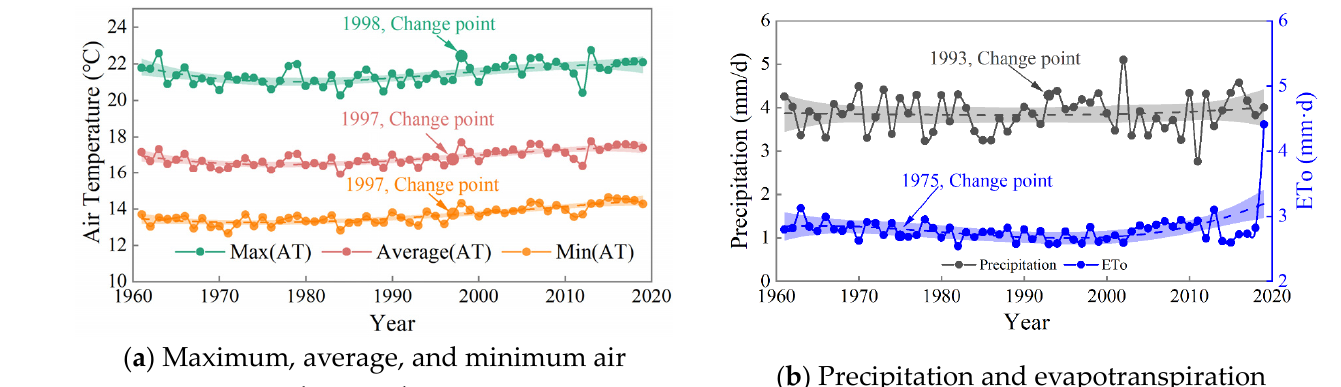
Figure 3. Interannual variation of meteorological elements.